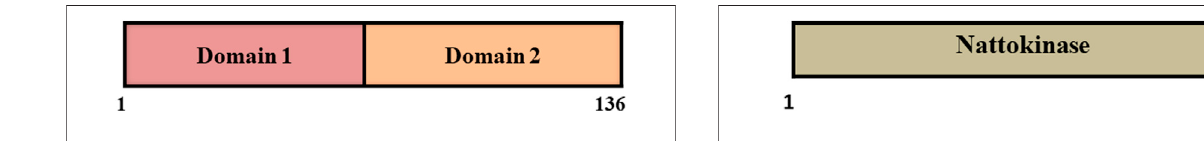
FIGURE2| Domain structure ofstaphylokinaseconsisting twodomains of equal size.